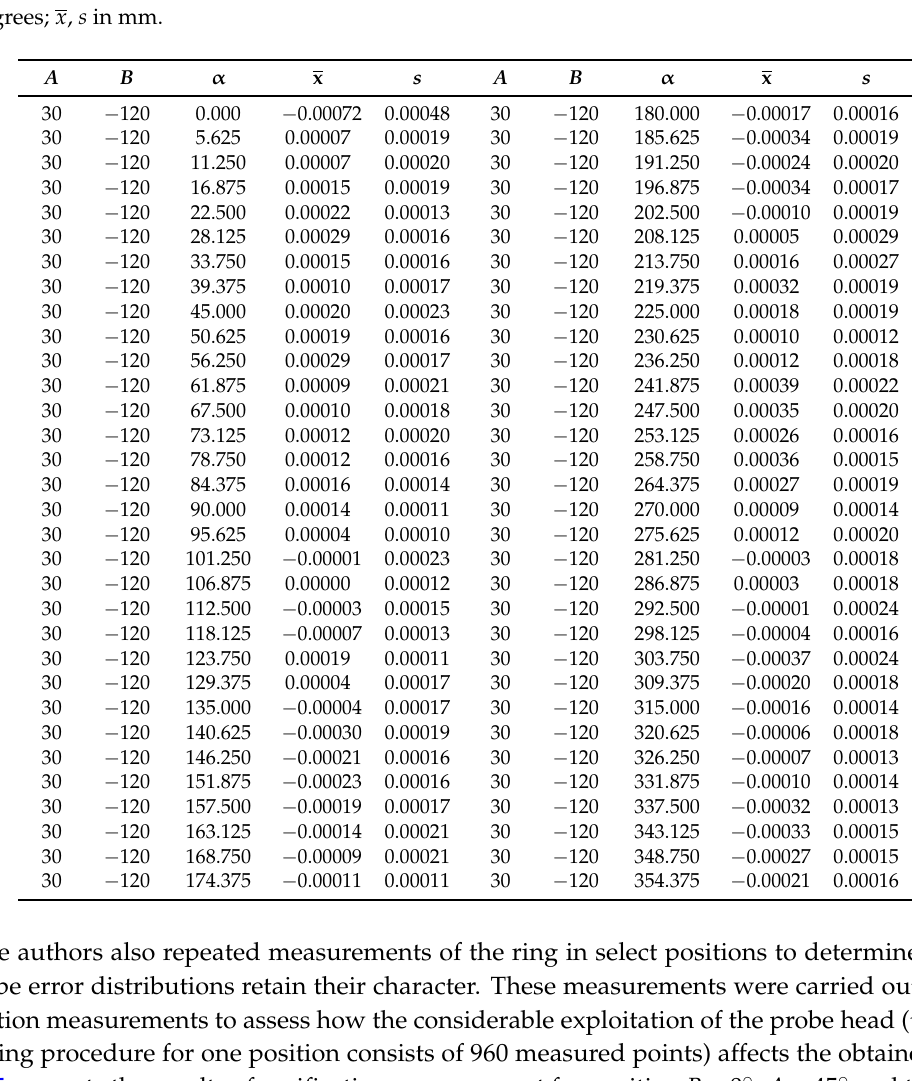
Table 1. Example of input data for simulative model for A = 30 ˝ and B = ´ 120 ˝ . A , B , α given in degrees; x , s in mm.